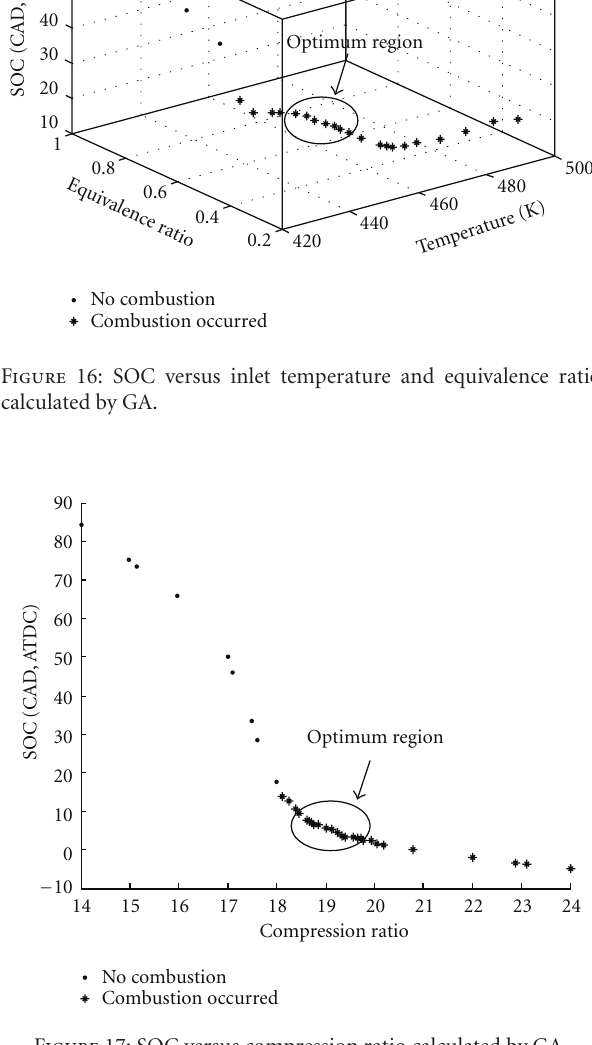
temperature, equivalence ratio, exhaust gas recirculation, compression ratio, ratio of the connecting rod length to the crank-arm radius, engine speed, and clearance